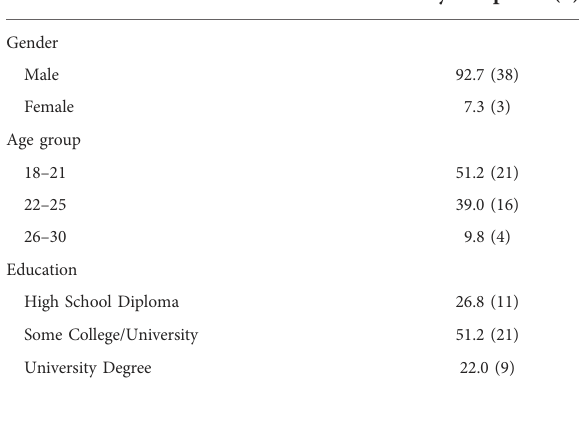
TABLE 1 List of sociodemographic factors of study sample ( N